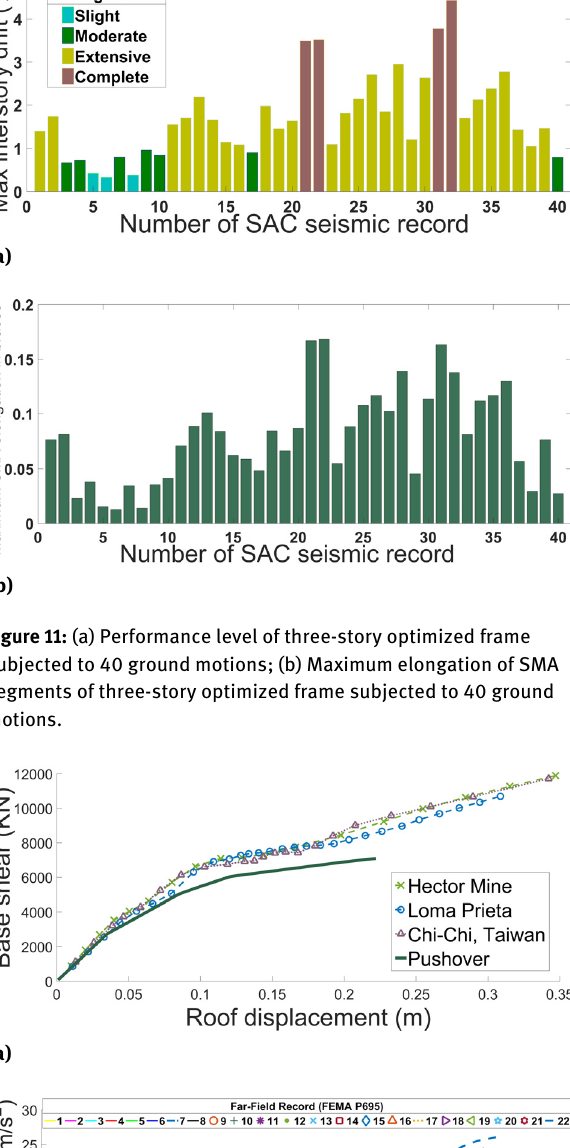
Table 3: Base Shear Related to Initial Yielding and Final Yielding of Structure, and Elastic